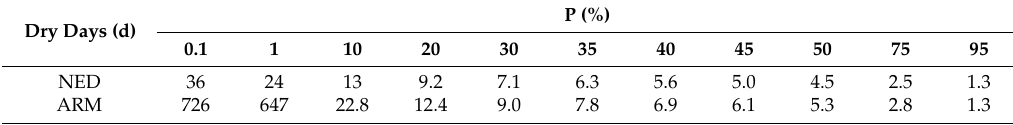
Table 2. Statistical parameters from dry periods.